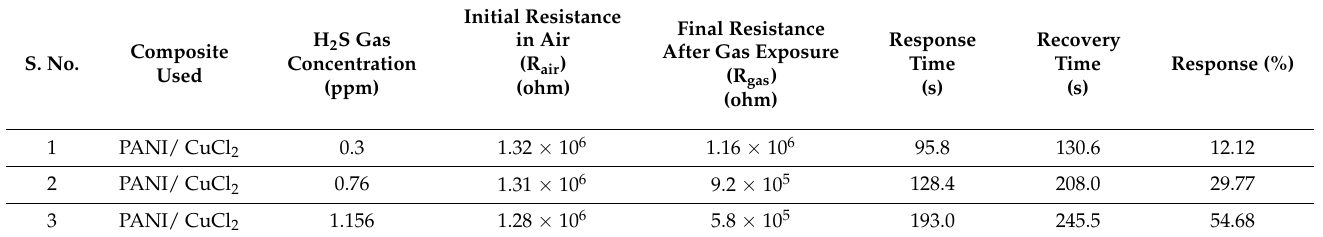
Table 1. Response and recovery behavior of PANI/CuCl 2 film-based sensor when exposed to H 2 S gas.